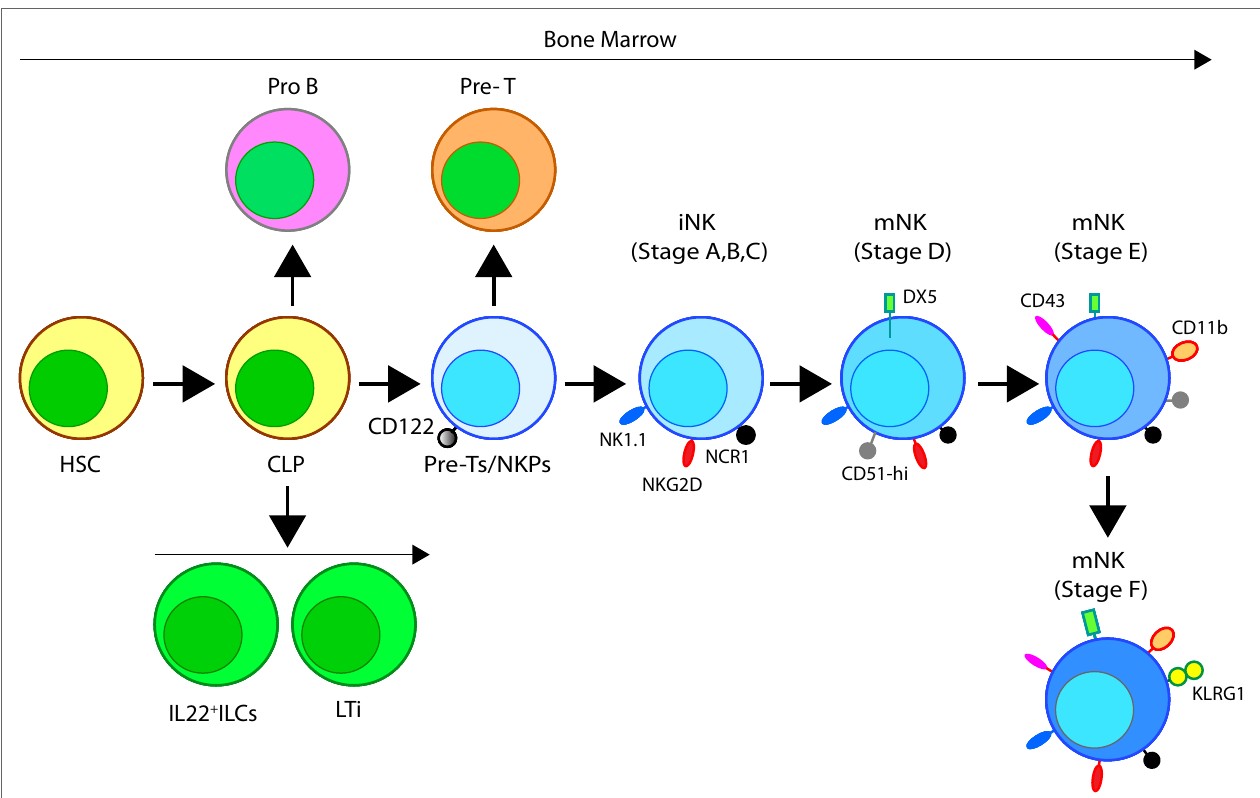
FiGURe 2 | Developmental origin of murine natural killer (NK) cells in the bone marrow (BM). Murine NK cells develop in the BM. A subset of multipotent HSCs commits to becoming oligopotent common lymphoid progenitors (CLPs). CLPs give rise to Pro-B, Pre-T, innate lymphoid cells (ILCs), lymphoid tissue inducers, and CD122 + Pre-T/early NK cell progenitor (NKP) lineages. Expression of NKG2D by the CD122 + NKPs mark the earliest transition of NKPs into committed immature NK cells (iNK, Stage A). This is followed by the expression of NK1.1 and NCR1 (Stages B and C). Expression of CD51 (Integrin α V) and CD49b (DX5, Integrin VLA-2 α ) defines the initial stage of mature NK (mNK) cells. Expression of CD43 (Leukosialin), CD11b (Mac-1), and the acquisition of distinct sets of Ly49s define the terminal stage of mNK cells (Stage E). mNK cells migrate into secondary lymphoid organs following the expression of Killer cell Lectin-like Receptor G1 (KLRG1) (Stage F) at least in part by a subset. Additional functional classifications of mNK cells are made using CD27 and CD11b.